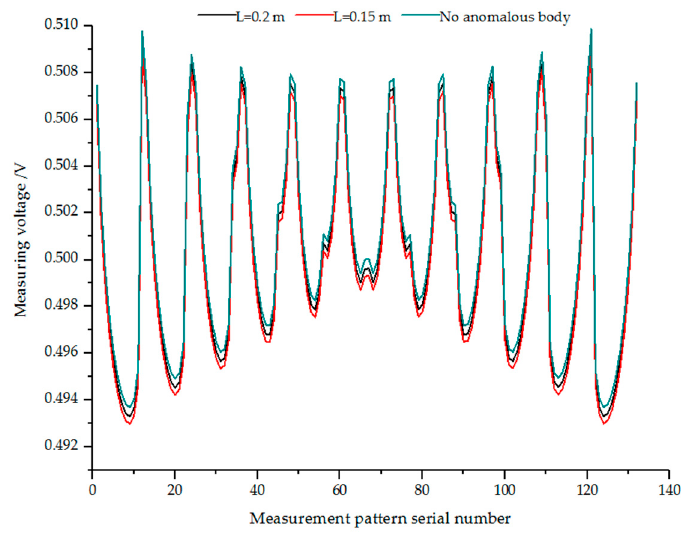
Figure 5. Measuring voltage of anomalous body at different distances and without anomalous body.